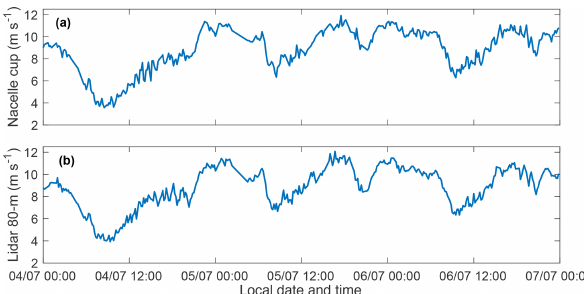
Figure 5. Time series from 00:00LT 4 July 2013 to 00:00LT 7 July 2013 of hub-height wind speeds measured by the cup anemometer on the nacelle of Turbine A (a) and 80m wind speeds measured by the lidar (b) .